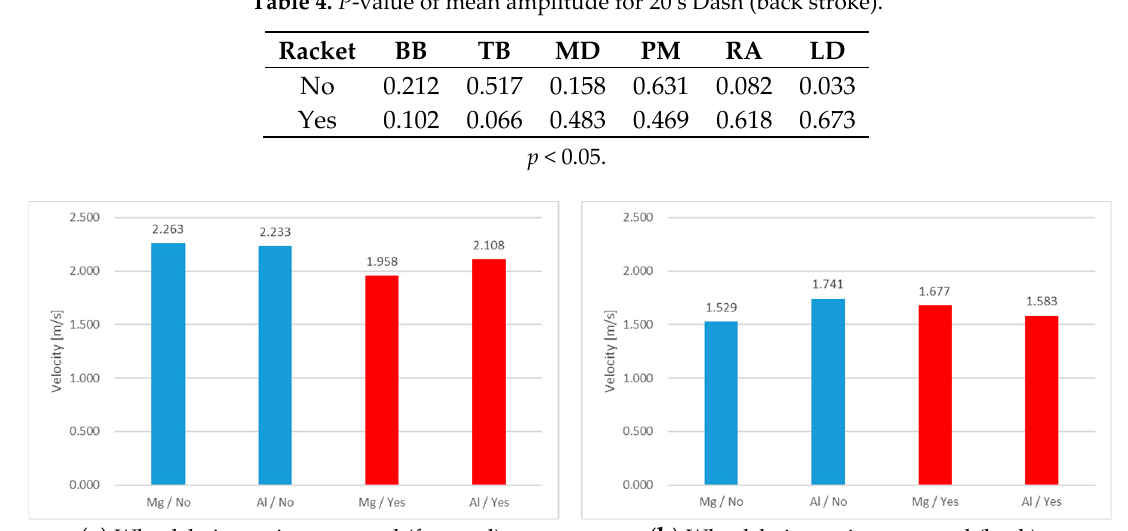
Table 4. P -value of mean amplitude for 20 s Dash (back stroke).